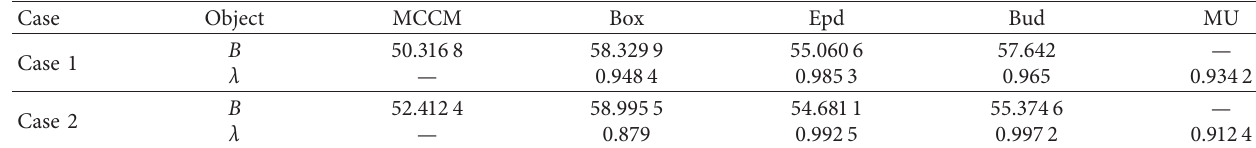
Table 7: Comparison with consensus models considering only one objective function.